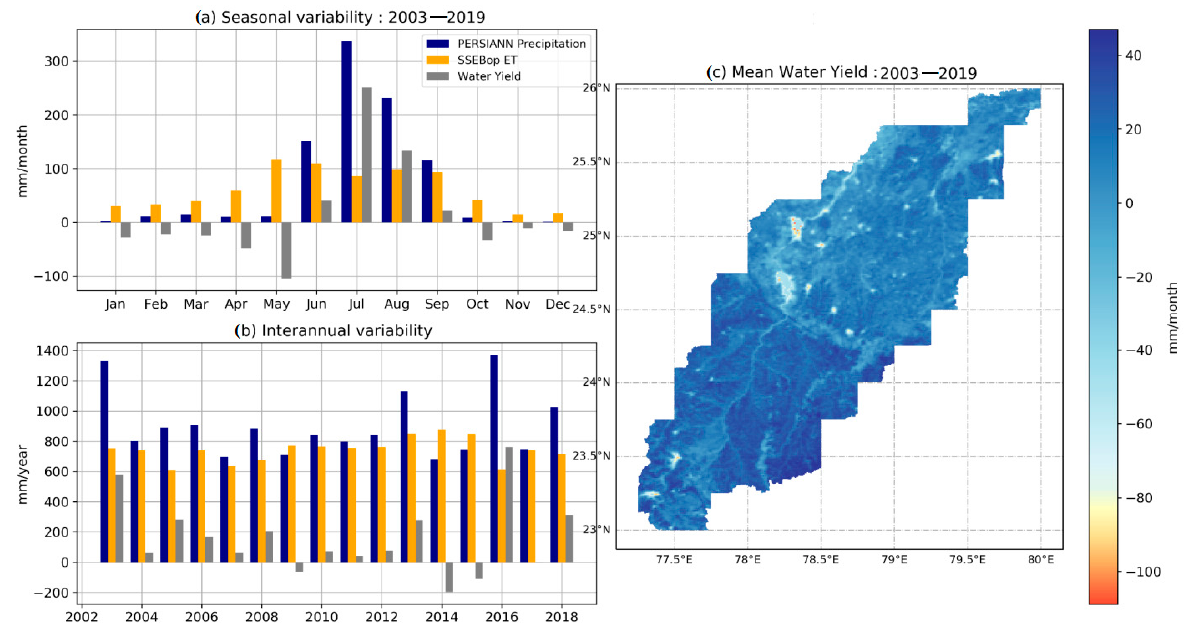
Figure 9. Figure shows seasonal and inter-annual variability in the precipitation, SSEBop ET, and water yield obtained from the PERSIANN precipitation for the period of 2003–2019. ( a ) seasonal variability plot of PERSIANN precipitation, SSEBop ET and water yield; ( b ) interannual variability; ( c ) mean water yield of period 2003–2019.